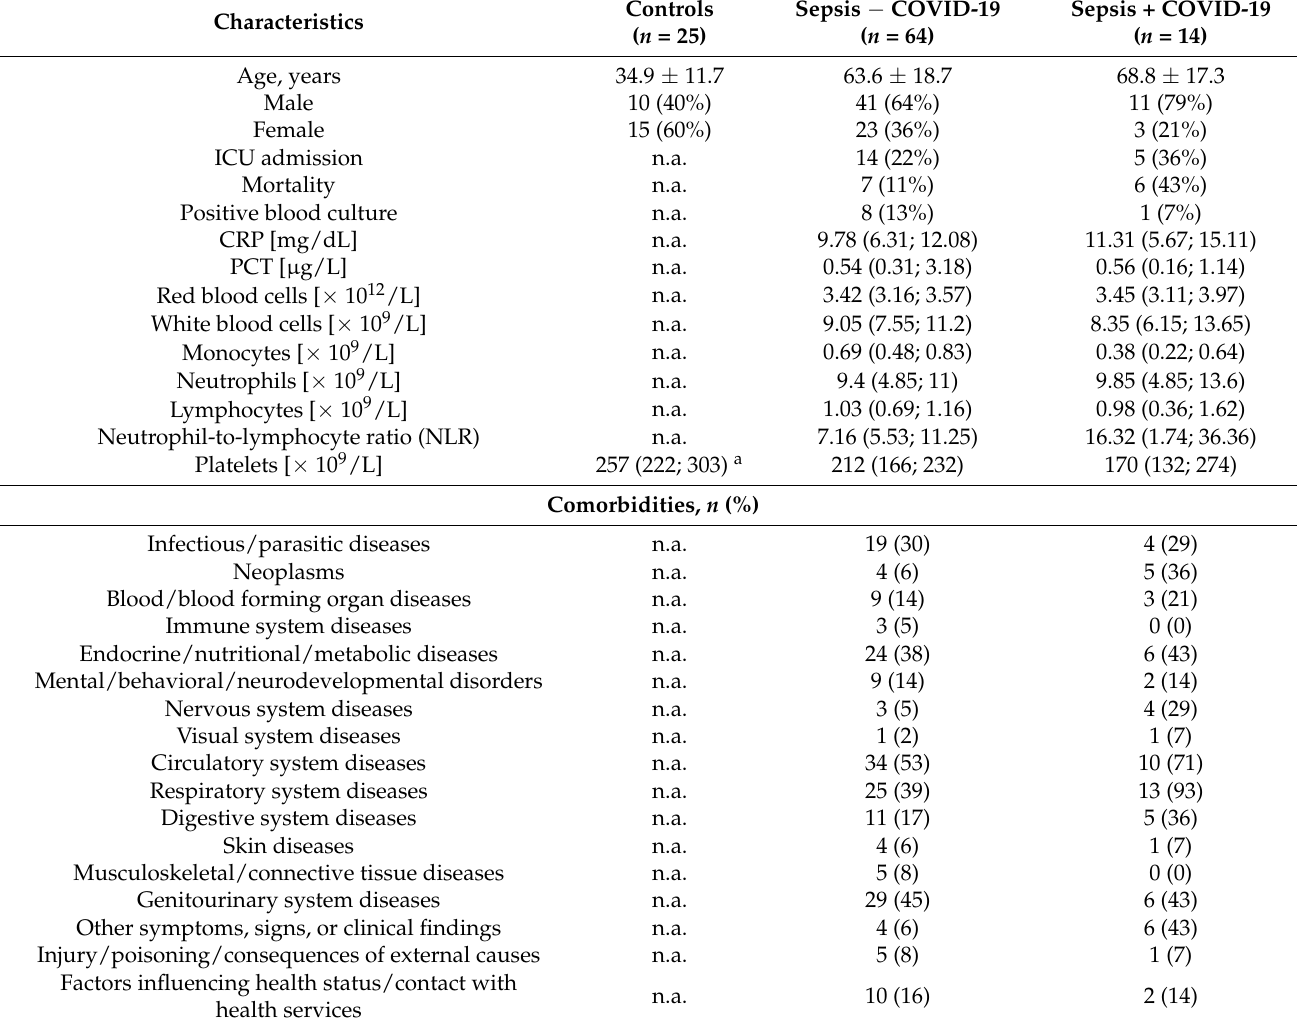
Table 1. Patient characteristics at baseline.